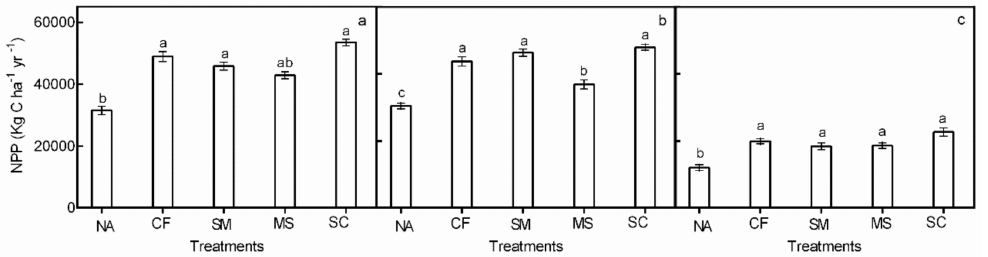
Figure 8. Net primary productivity (NPP) in 2014 ( a ), 2015 ( b ), and 2016 ( c ) by soil amendment treatment in maize. NA, no amendment; CF, chemical fertilizer; SM, swine manure; MS, maize stover; and SC, swine manure + chemical fertilizer. Within a year, bars with di ff erent letters are significantly di ff erent ( p ≤ 0.05). Error bars denote standard